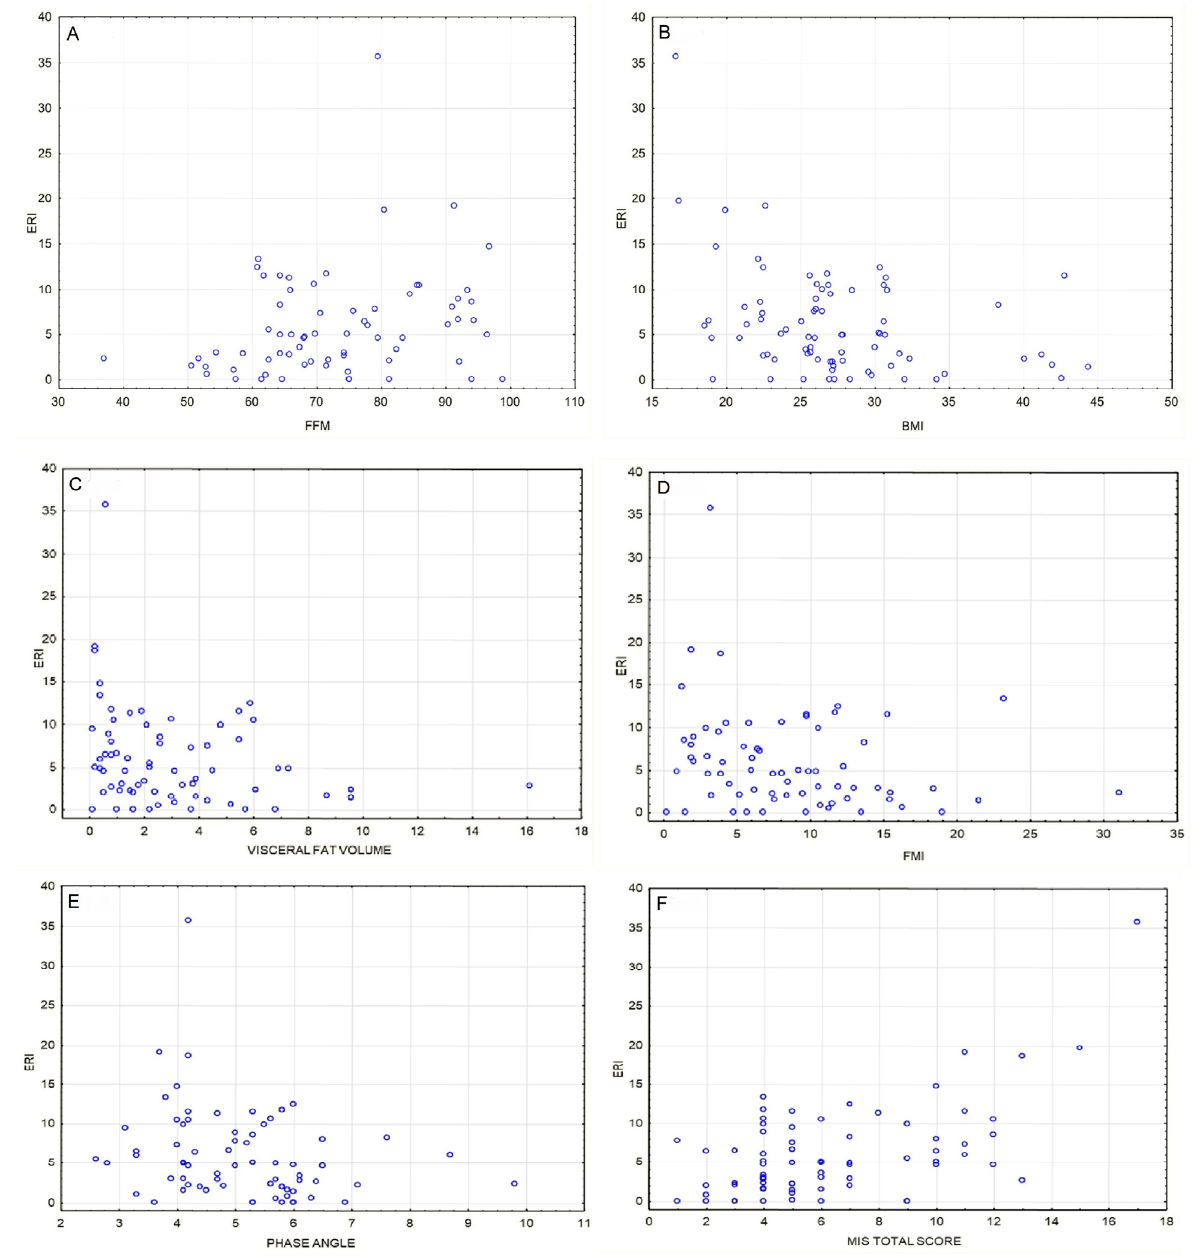
Figure 2. ( A ) Positive correlation between fat-free mass [%] and ERI value [IU/kg/g/dL/week] ( ρ = 0.25, p = 0.035). ( B ) Inverse correlation between BMI [kg/m 2 ] and ERI value [IU/kg/g/dL/week] ( ρ = − 0.33, p = 0.03). ( C ) Inverse correlation between visceral fat volume [l] and ERI value [IU/kg/g/dL/week] ( ρ = − 0.29, p = 0.018). ( D ) Inverse correlation between fat mass index [kg/m 2 ] and ERI value [IU/kg/g/dL/week] ( ρ = − 0.25, p = 0.037). ( E ) Inverse correlation between phase angle (°) and ERI value [IU/kg/g/dL/week] ( ρ = − 0.33, p = 0.006). ( F ) Positive correlation between ERI [IU/kg/g/dL/week] and MIS total score ( ρ = 0.41, p = 0.00041); this association remains significant after Bonferroni correction.